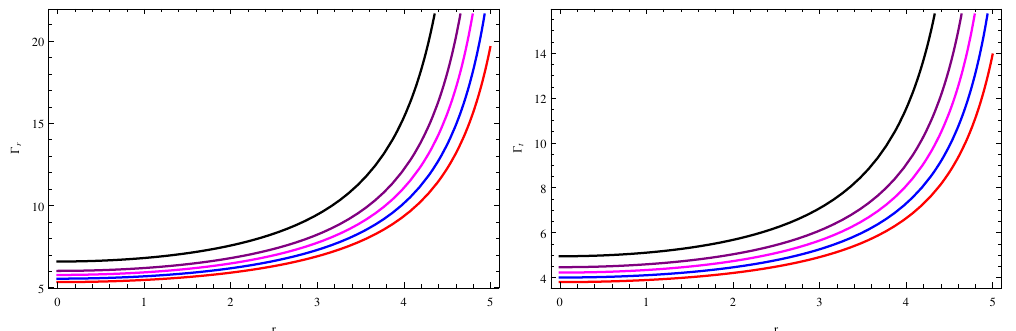
Figure 9. Plot of Γ r and Γ t versus r for the strange star candidate LMC X − 4. The red, purple, magenta, blue and black colors represent, respectively, cases (cid:118) = 0, (cid:118) = 0.5, (cid:118) = 1, (cid:118) = 1.5 and (cid:118) = 2.